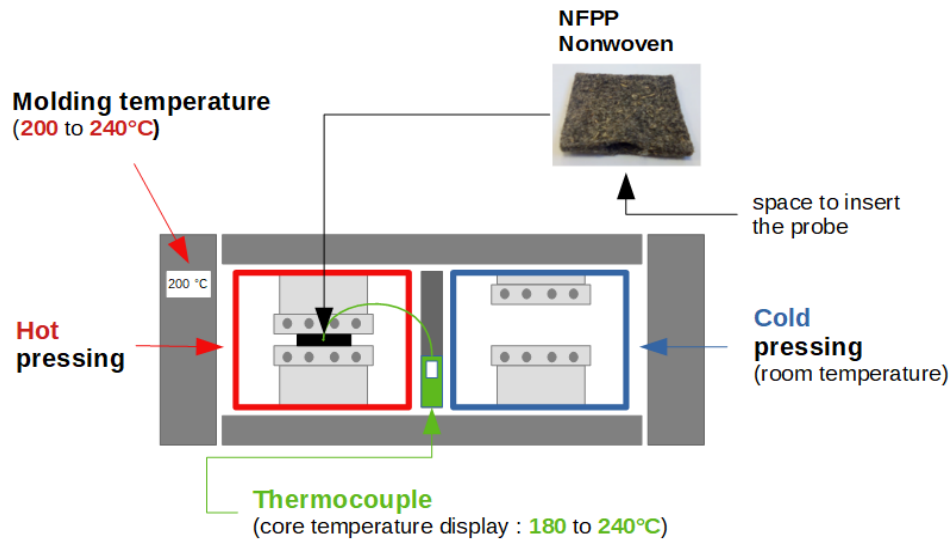
Figure 1. Composite manufacturing process by thermocompression and the placement of the ther- mocouple in the NFPP nonwoven to measure the core temperature in the nonwoven during the hot- pressing process.